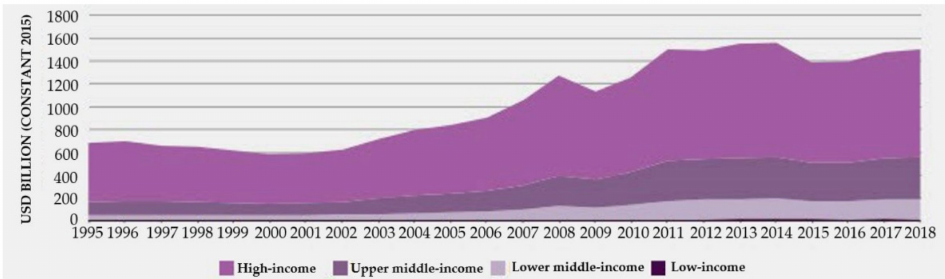
Figure 4. Agri-food exports 1995–2018